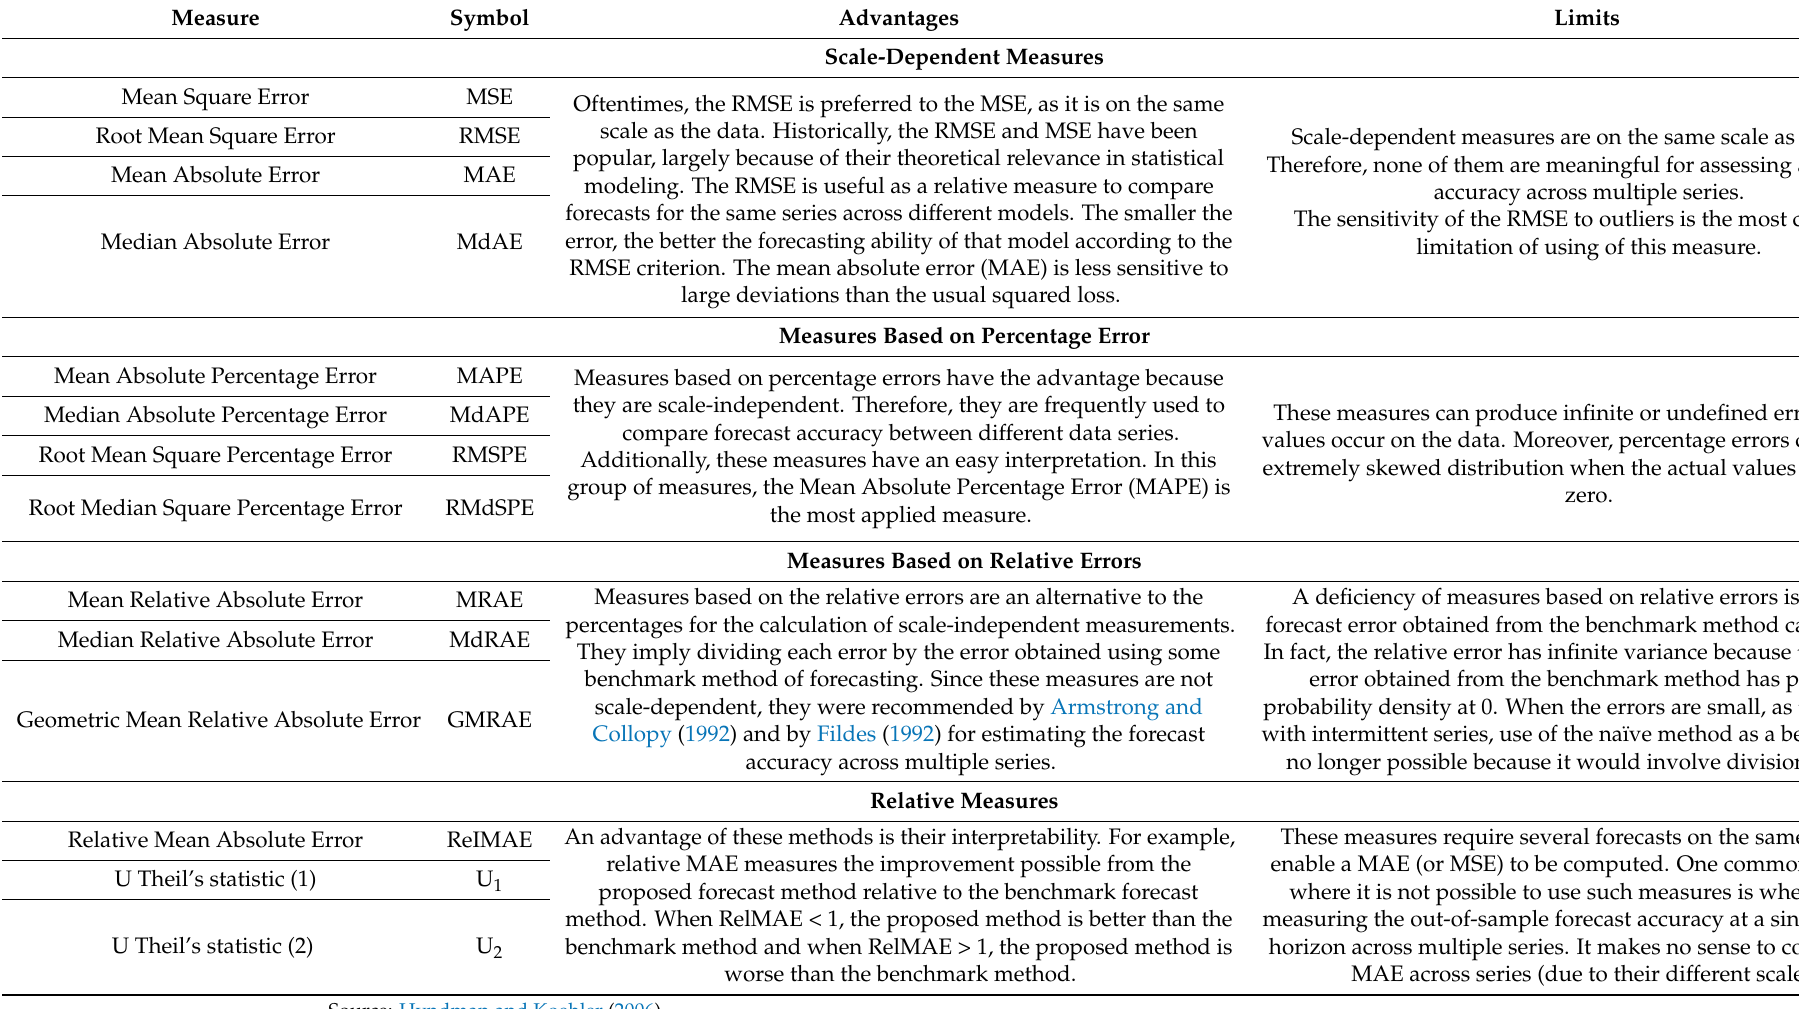
Table 7. Advantages and limits of the methods used to assess forecast